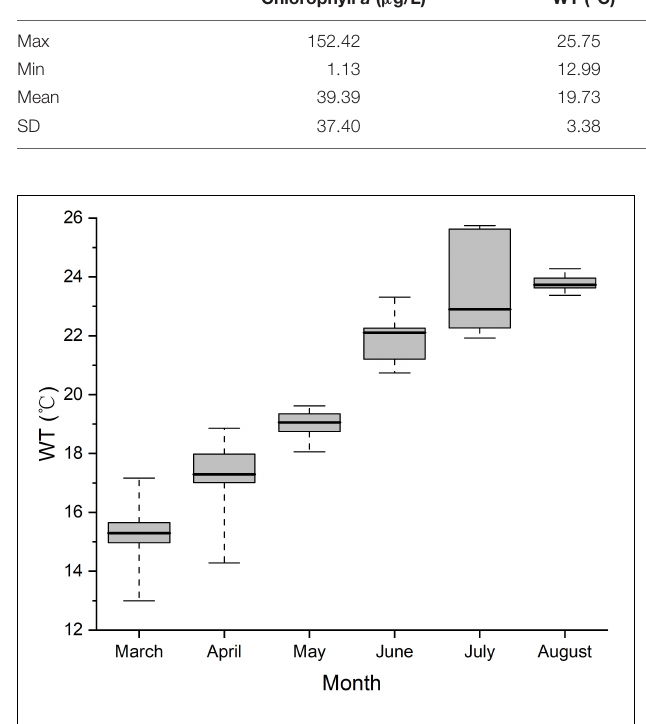
FIGURE 2 | Boxplots showing the spatiotemporal variation of water temperature in the Xiangxi Bay of Three Gorges Reservoir.